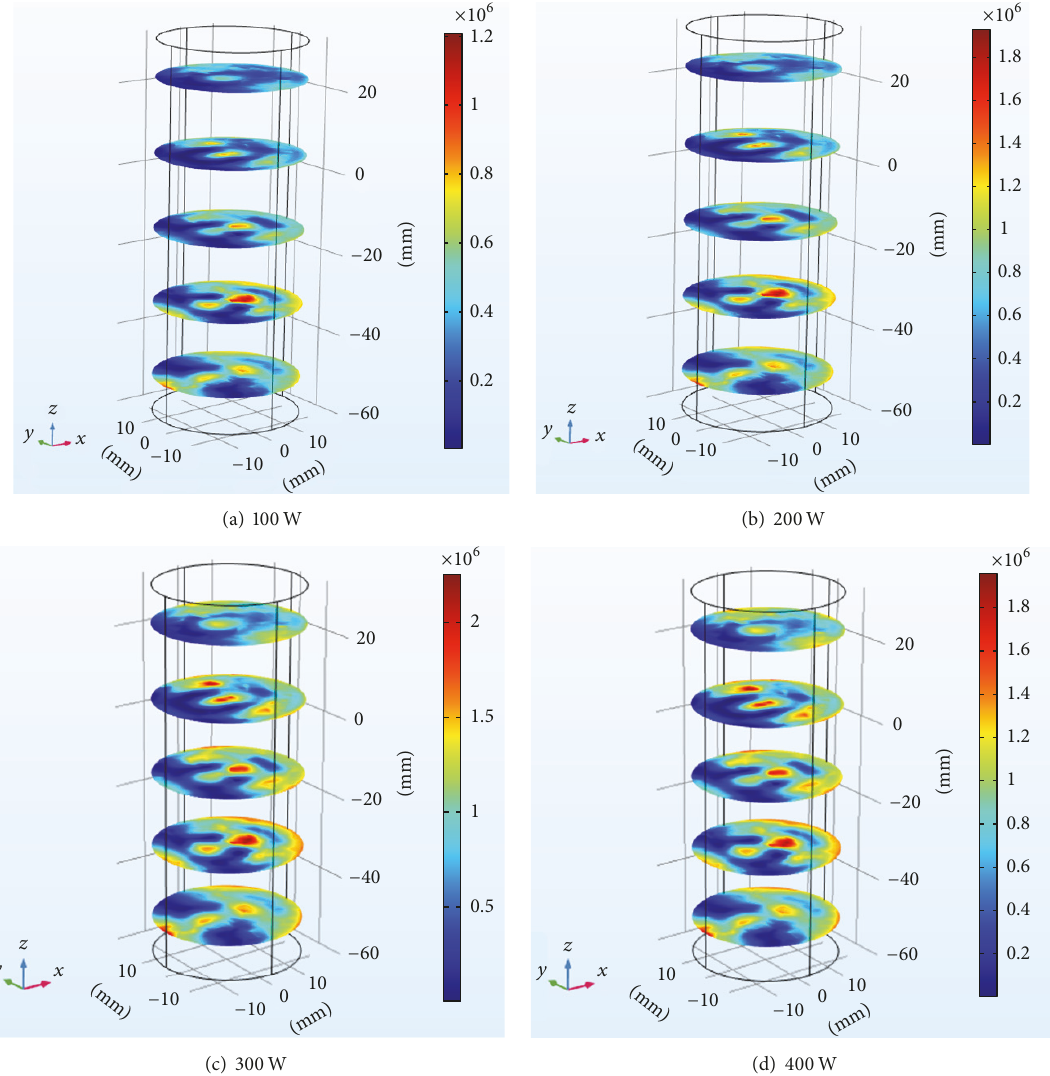
Figure 4: Distribution of microwave energy absorption in extraction vial at extraction time of 80 s under 4 microwave powers (ethanol concentration of 60% and the ratio of solid to liquid of 1: